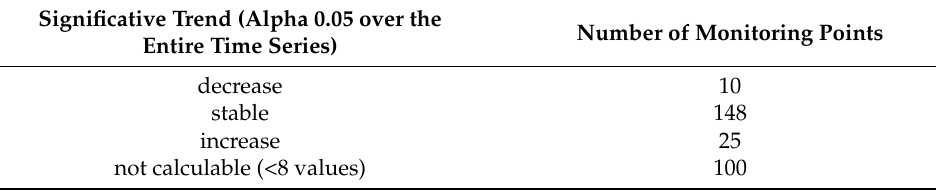
Table 6. Test result for the calculation of significant trends by station. Significative Trend (Alpha 0.05 over the Entire Time Se-